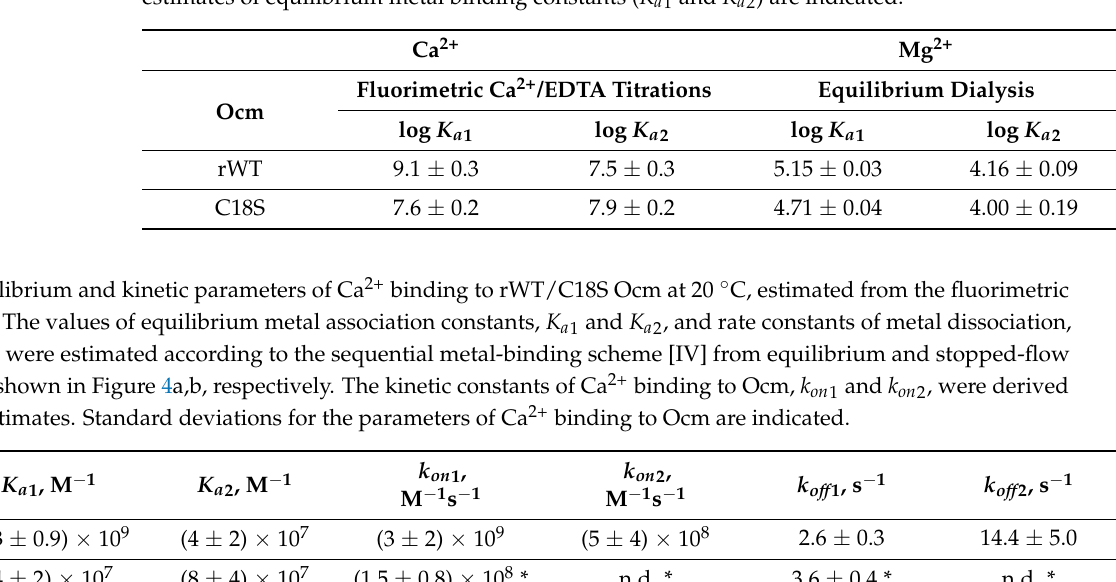
Table 4. The values of equilibrium Ca 2+ association constants for rWT/C18S Ocm at 20 ◦ C estimated from the experimental data shown in Figure 4a (fluorimetric Ca 2+ /EDTA titrations) and 5 (equilib- rium dialysis) according to the sequential metal-binding scheme [IV]. Standard deviations for the estimates of equilibrium metal binding constants ( K a 1 and K a 2 ) are indicated.